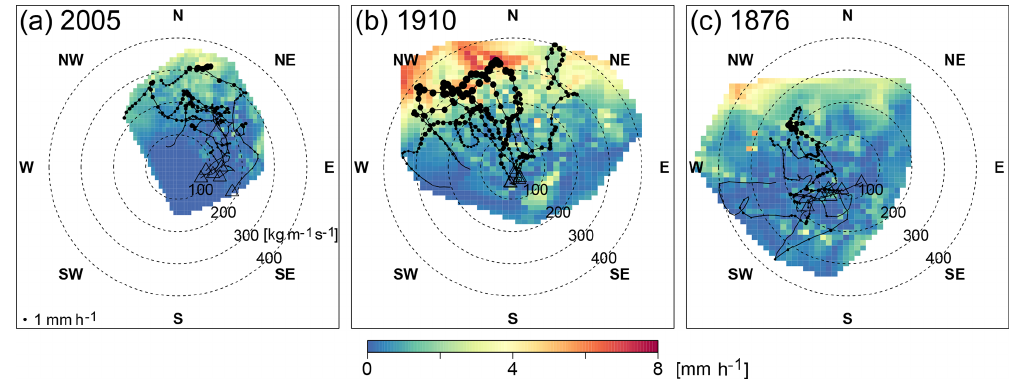
Figure 9. Hourly precipitation (mmh − 1 ; color shade) as a function of IVT (kgm − 1 s − 1 ; dashed circles) over northeastern Switzerland during 48h periods starting at (a) 21 August 2005 06:00UTC, (b) 13 June 1910 06:00UTC, and (c) 11 June 1876 06:00UTC. Both precipitation and IVT are averages over the control area in northeastern Switzerland in the 3km WRF domain. The 480 black dots represent 48 different time steps for a subset of 10 members (see Sect. 3.1). The size of the dots represents precipitation intensity; the location of the dots on the radial diagram represents IVT: the azimuth represents the direction of IVT and the radial component its intensity. All time steps of a same member are connected by a line, with the last time step marked by a triangle. The corresponding two-dimensional interpolation of the precipitation intensity is shown in color. The color maps hence represent the mean precipitation intensity as a function of IVT intensity and